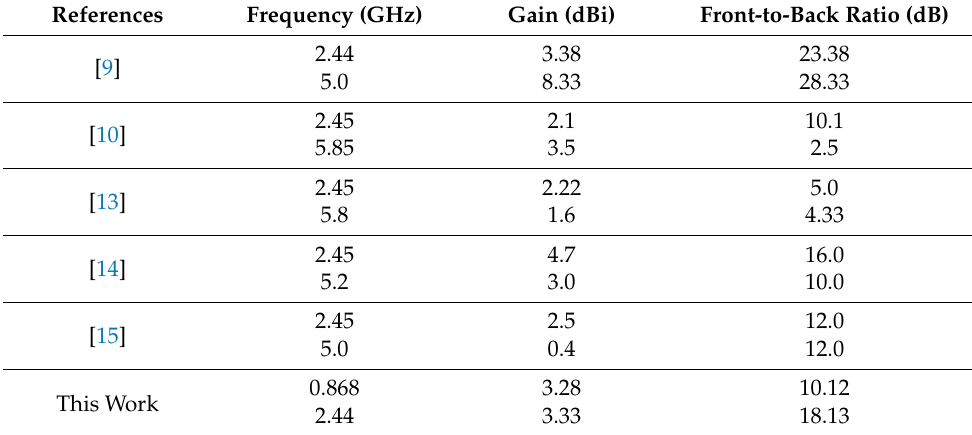
Table 2. Comparison of Dual-Band Wearable